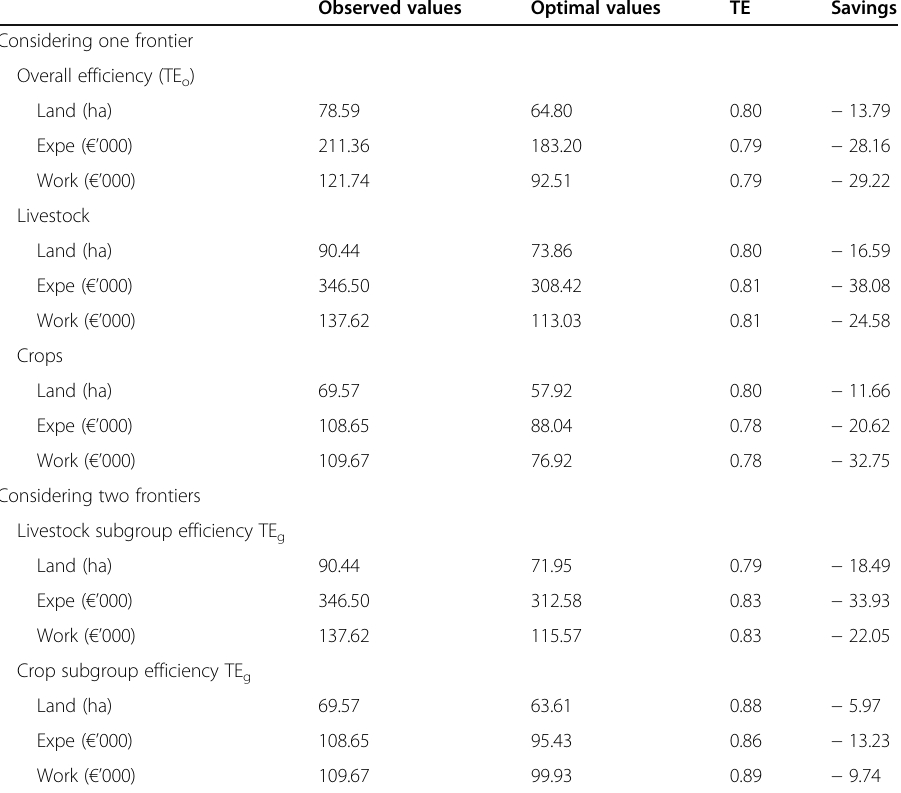
Table 5 Optimal (fully efficient) input use estimated by DEA (average values of TE VRS